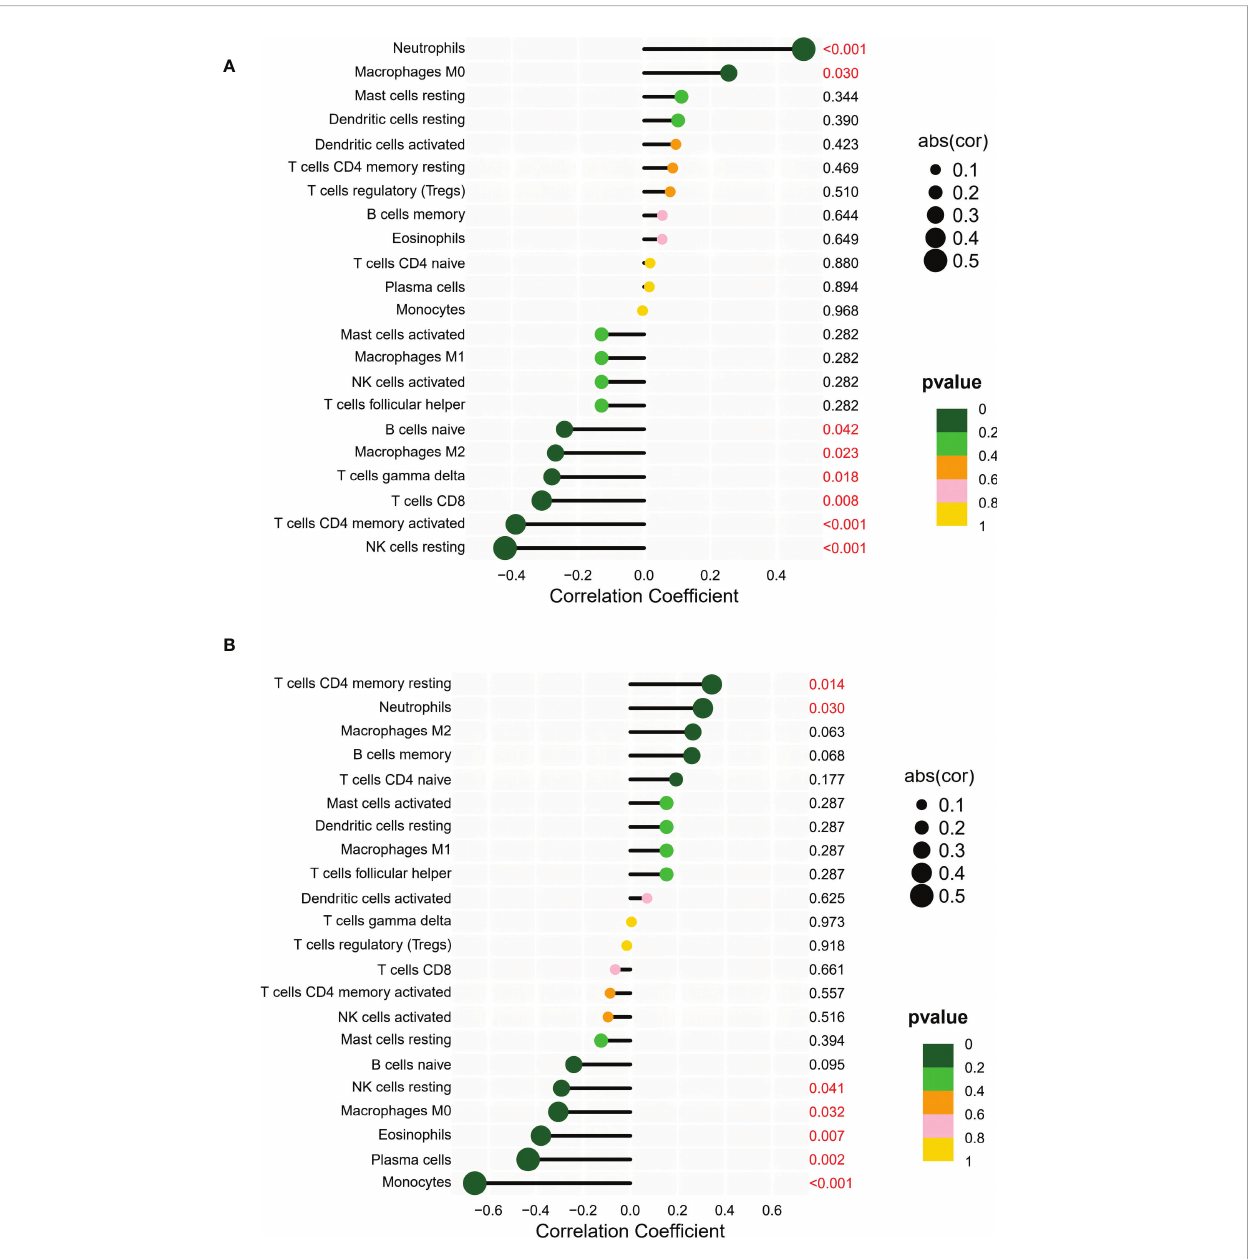
FIGURE 7 (A) Correlation analysis between PAN3 and in fi ltrating immune cells in AS samples where red represented the positive correlation with a signi fi cant difference. (B) Correlation analysis between PAN3 and in fi ltrating immune cells in UC samples where red represented the positive correlation with a signi fi cant